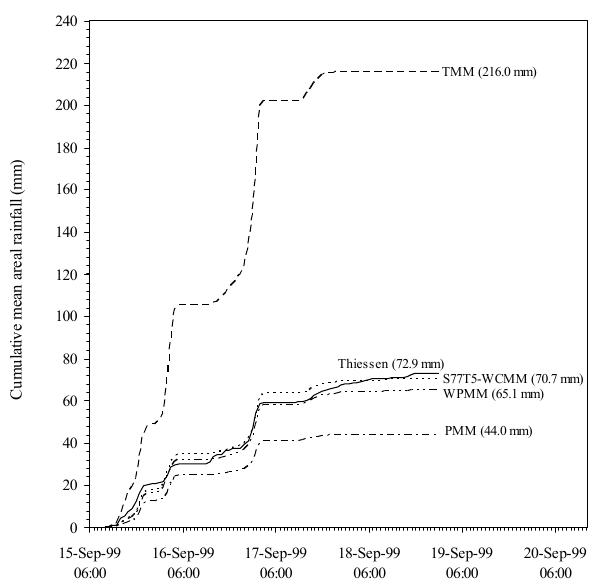
Fig. 9. Cumulative mean areal rainfall estimates based on different Z e − R pair matching techniques.